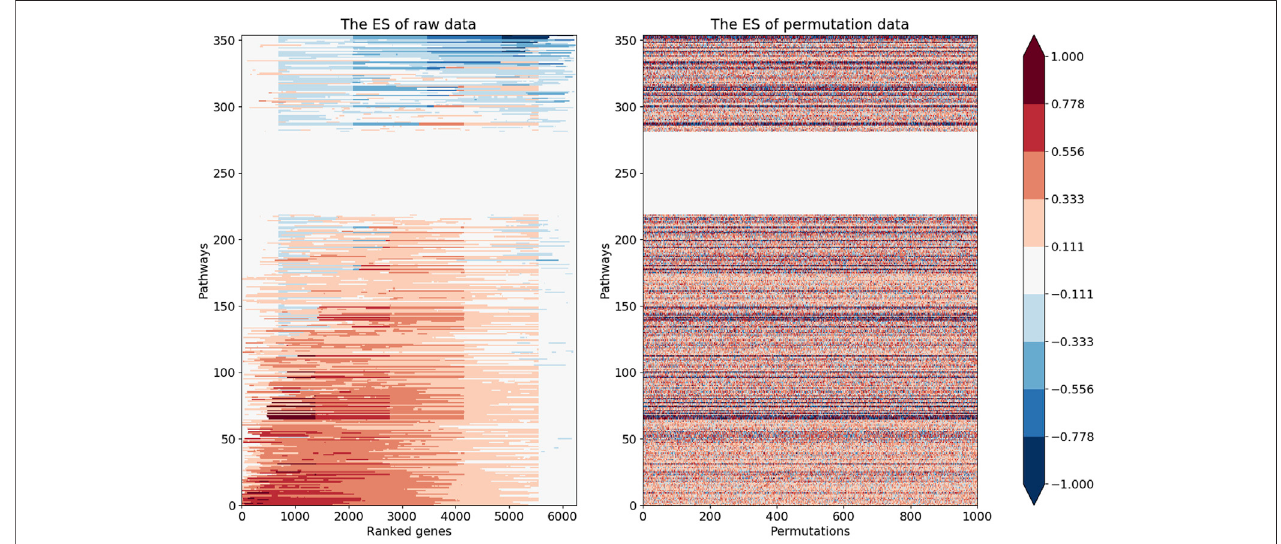
FIGURE2| Theleft heatmapdemonstratedESvaluesforall the354pathways inGSEA.Theright heatmapillustratedrandomly generated maximum ESvaluesfor the corresponding pathways.